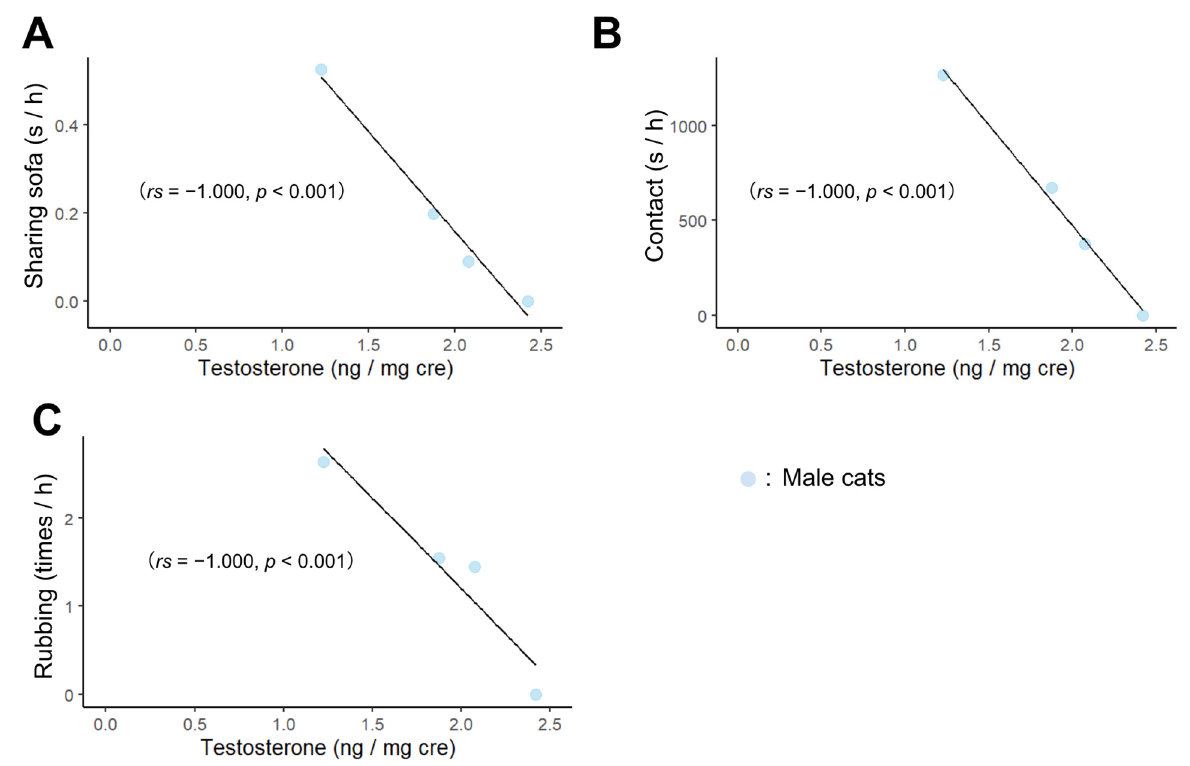
Figure 3. Correlation between behavior towards experimenters and testosterone concentrations. ( A – C ) indicate the relationship between testosterone concentration and the following behaviors, ( A ) Sharing sofa, ( B ) Contact, ( C ) Rubbing.